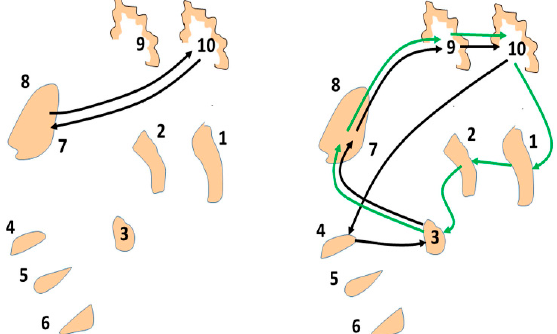
Figure 2. Schematic representation of the various components of the basal ganglia–thalamic–cortical system, demonstrating three oscillator architectures out of a greater number of possible oscillators. Represented are the following various structures: 1, putamen (as representative of the striatum); 2, globus pallidus externa; 3, globus pallidus interna; 4, subthalamic nucleus; 5, substantia nigra pars reticulata; 6, substantia nigra pars compacta (location of the cell bodies that utilize